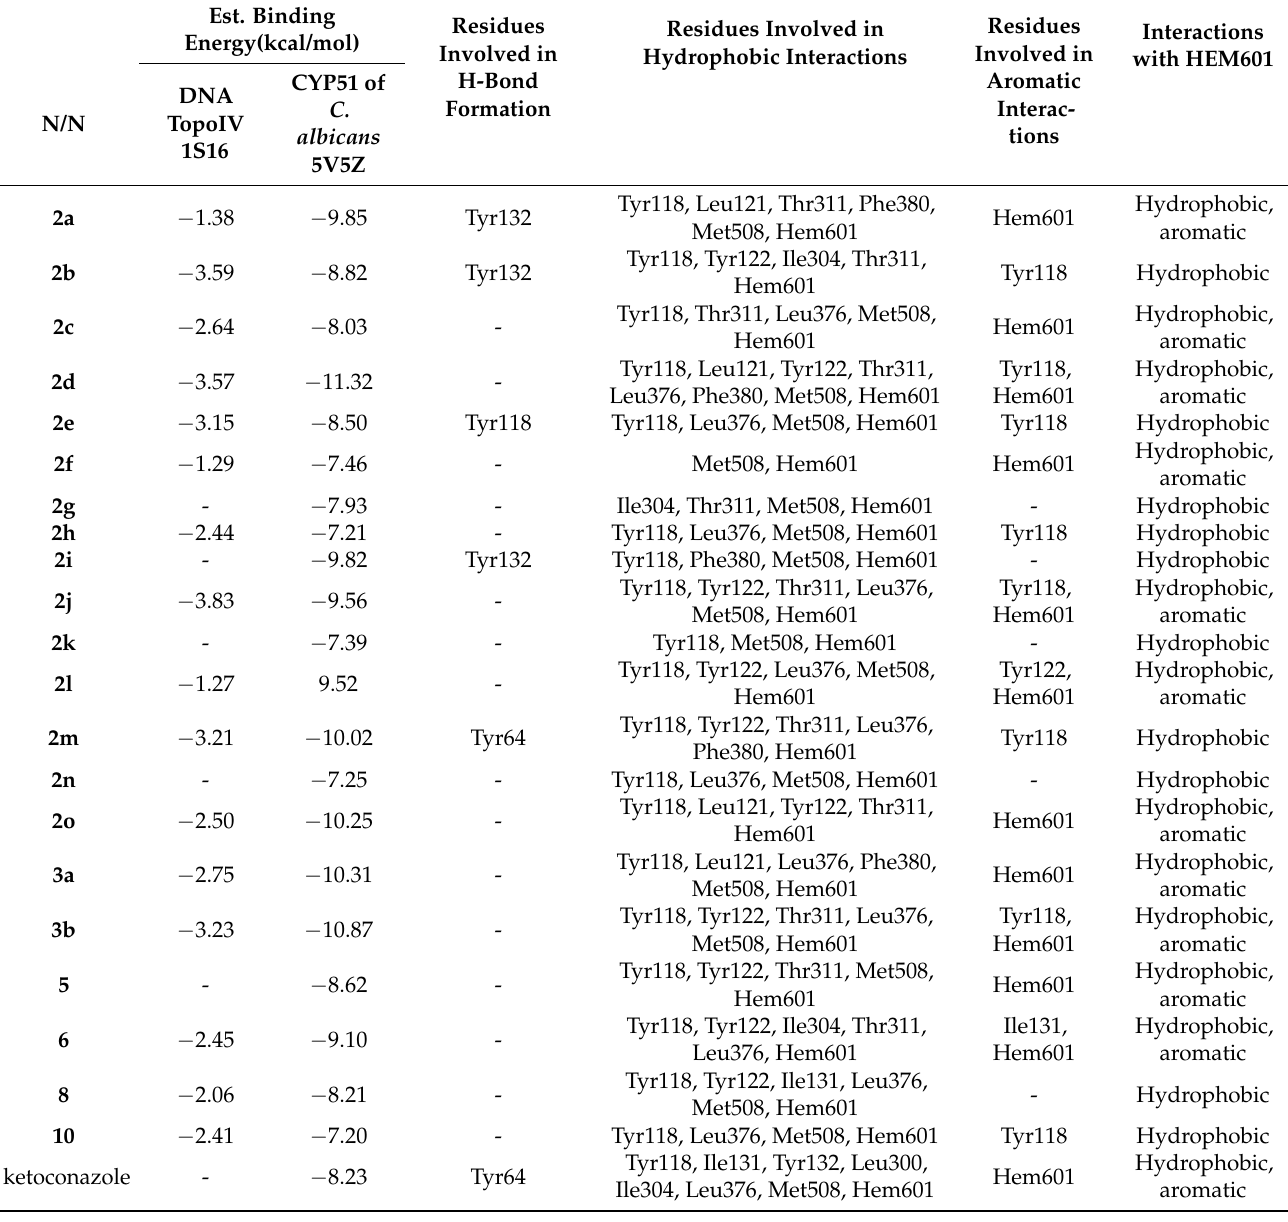
Table 4. Molecular docking free binding energies (kcal/mol) to antifungal